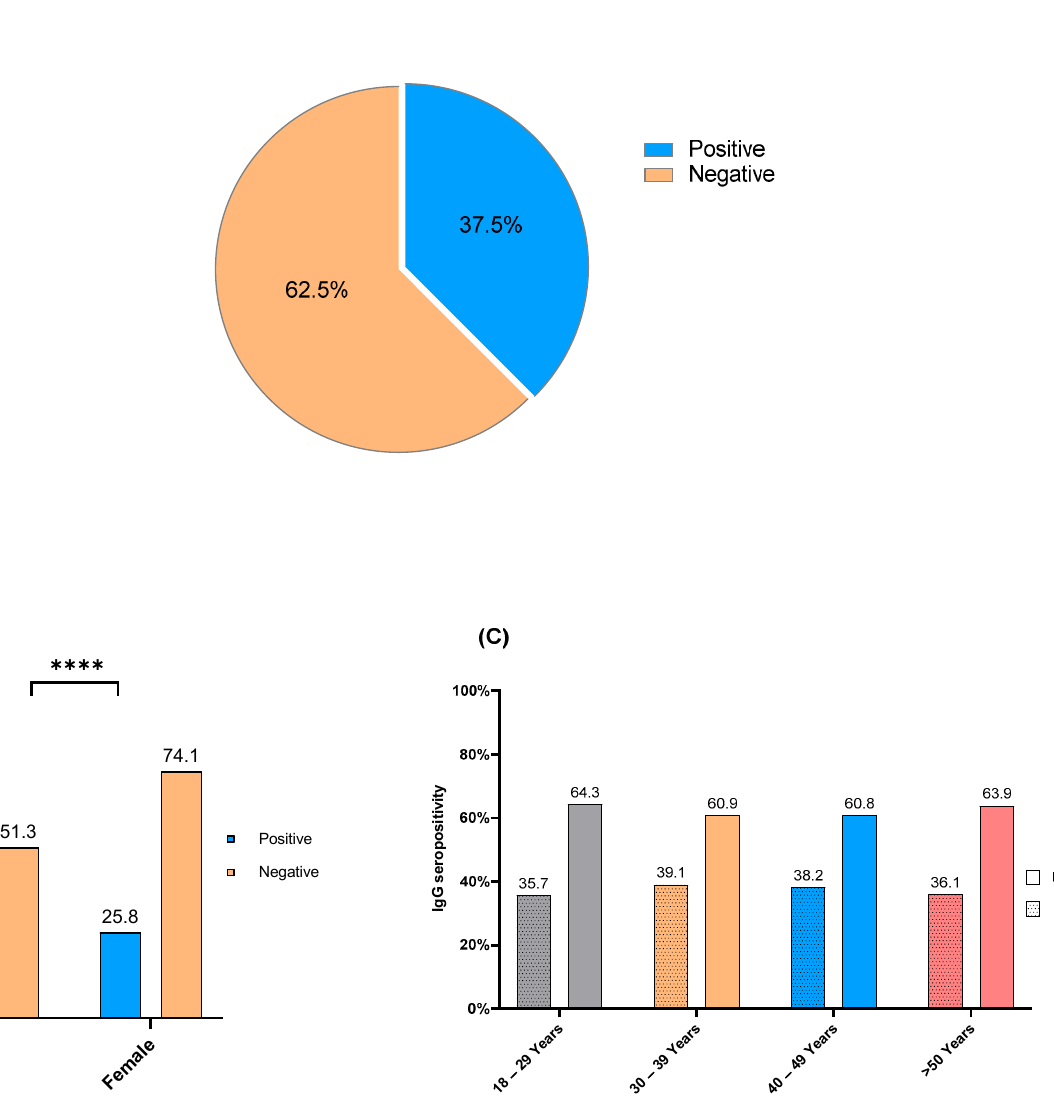
Figure 2. L. pneumophila IgG seropositivity in the community. ( A ) Seroprevalence in the sample population, ( B ) proportions of IgG seropositivity in different genders, ( C ) distribution of IgG seropositivity for different age groups. (****) p -value < 0.0001.